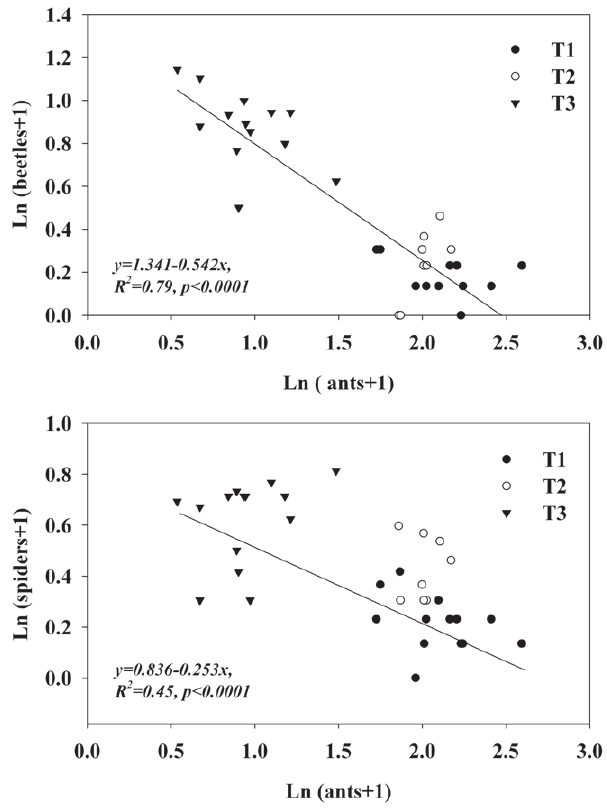
Figure S1 The effects of ant-exclusion from canopy on the abundances of ants, beetles, spiders and predators on the forest floor (mean, SE). Table S1 The leaf area index (LAI), cover and tree densities in the treated and control plots. Table S2 The effects of ant-exclusion from canopy on the abundances of ants, beetles spiders and predators on the forest floor.